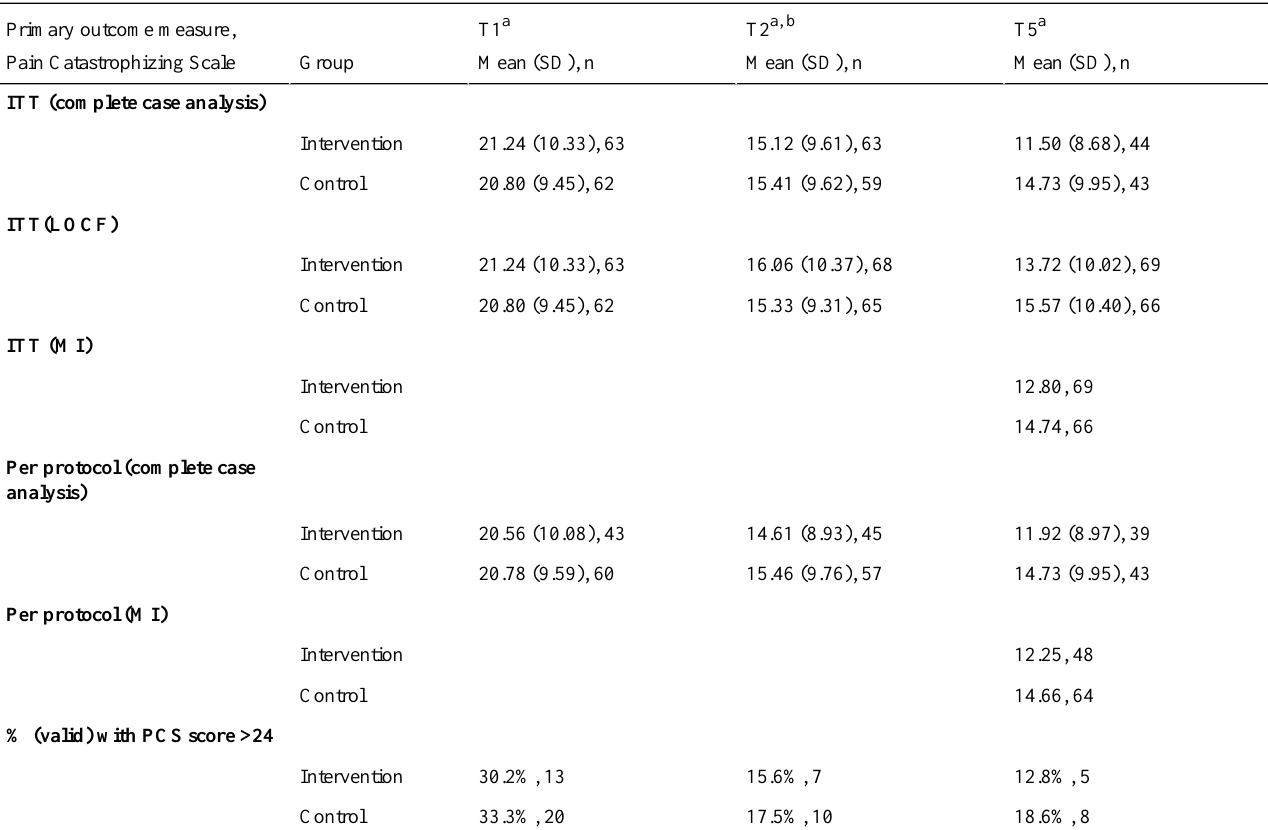
Table 2. Means and standard deviations for the primary outcome at admission to the inpatient rehabilitation (T1), at discharge (T2), and 11 months (T5) after the intervention